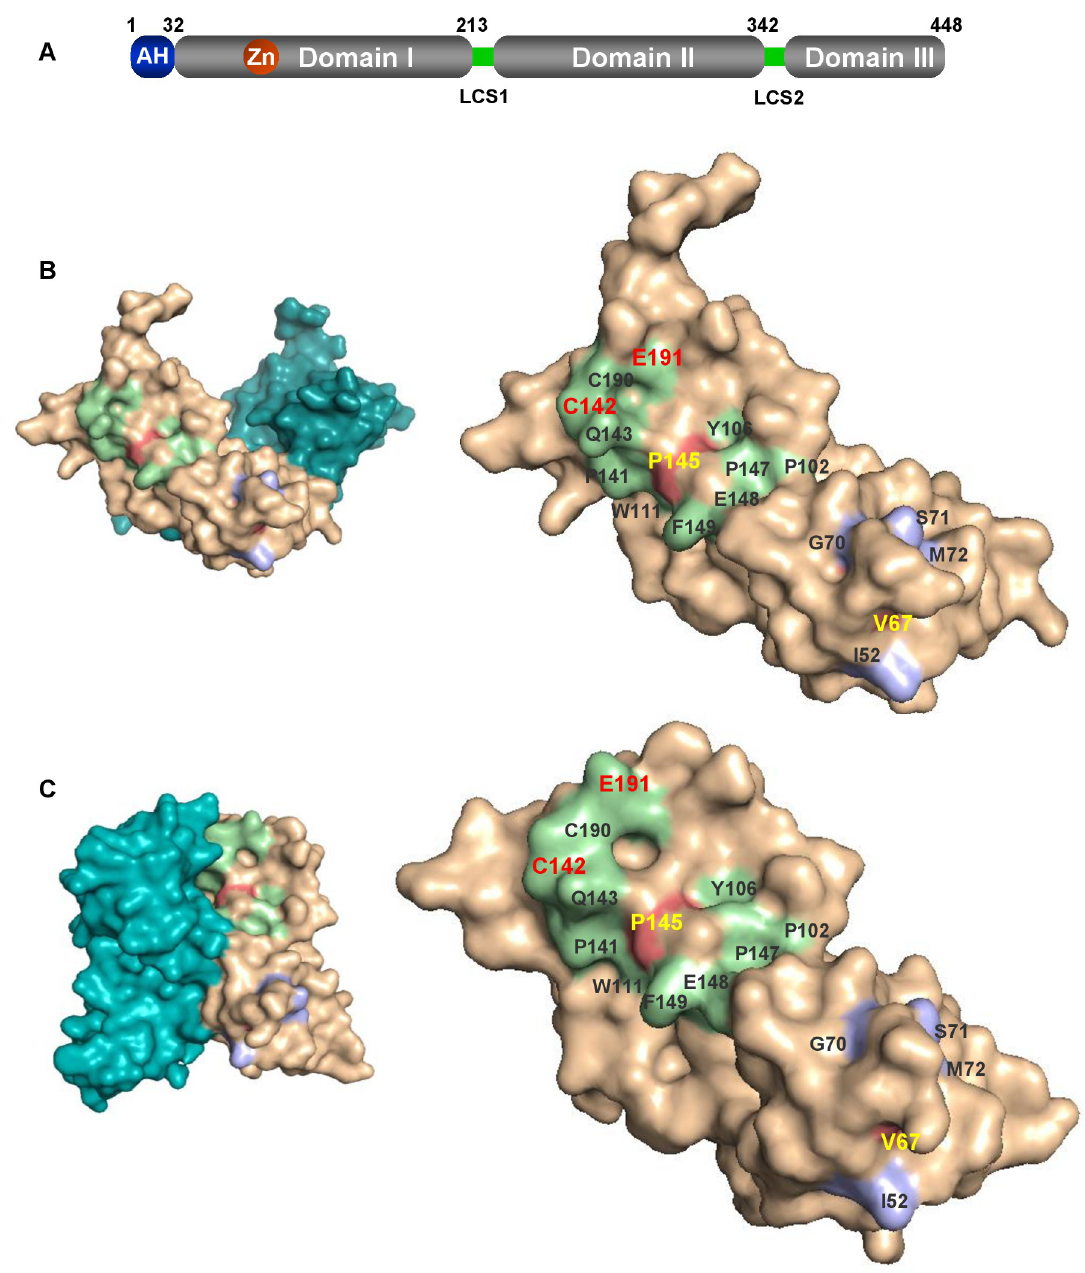
Fig 1. Location of mutated residues in DI. (A) Structure of NS5A illustrating the three domains. AH: amphipathic helix (blue), LCS: low complexity sequence (green). ( B, C) Conserved and surface exposed residues proximal to V67 (blue) and P145 (green) are displayed in the two NS5A DI (genotype 1b) structures 1ZH1 ( B) and 3FQM (C) . Dimeric forms are shown on the left, with the monomers on the